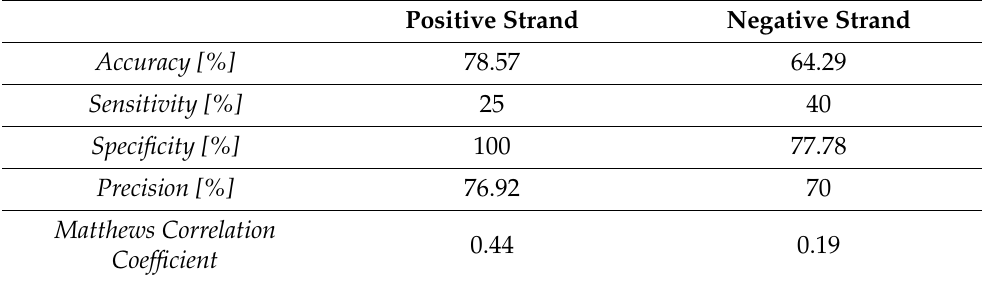
Table 1. Standard performance measure for both